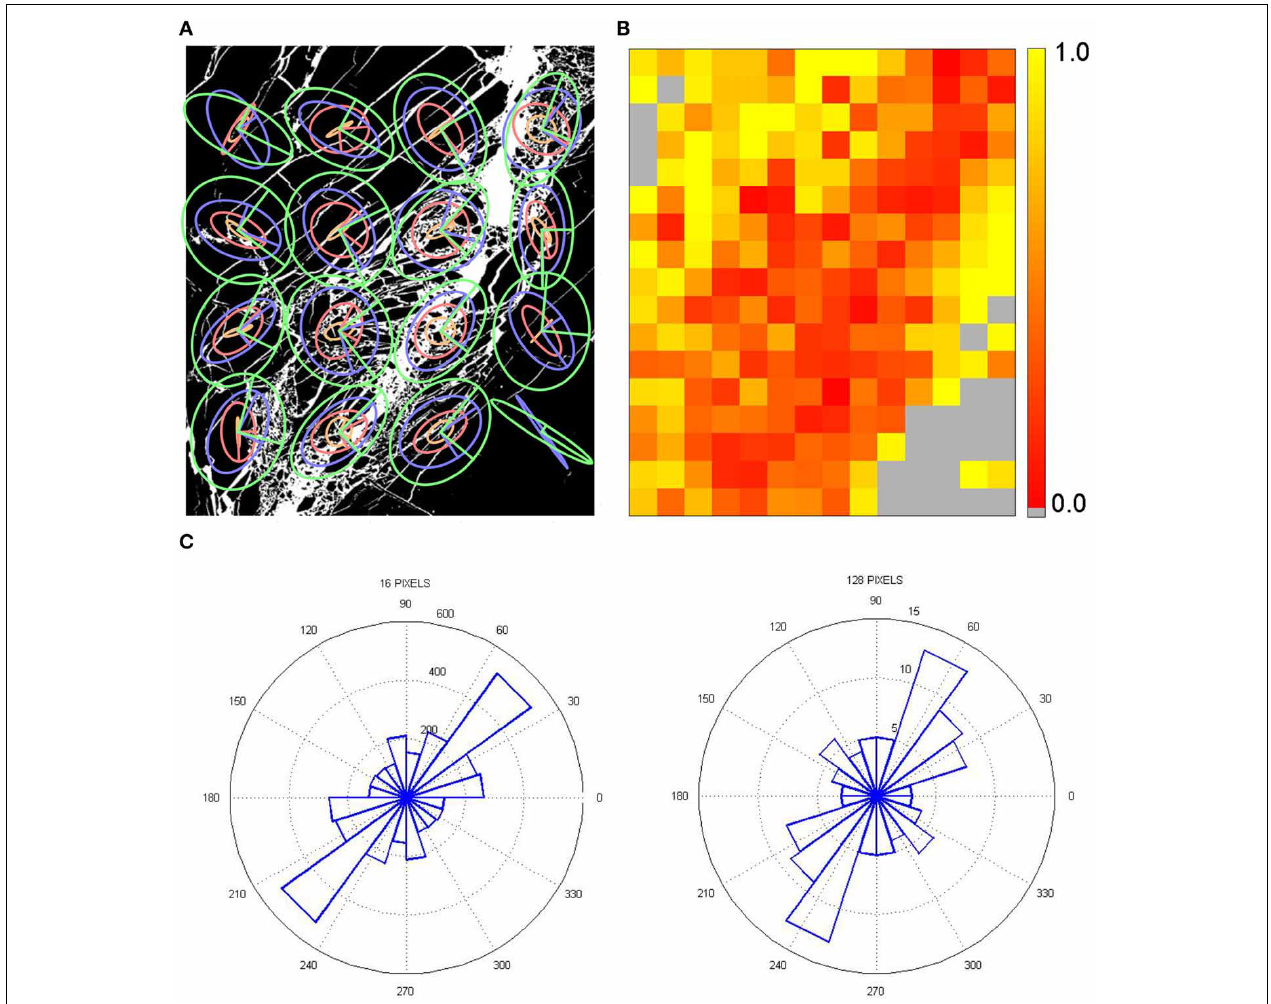
FIGURE 5 | Analysis of granite (Figure 1B). (A) Analysis in position, orientation and scale. There are 4 × 4 analysis boxes placed on a grid of 110 pixels step centered on the image. Concentric ellipses represent measurements at 32 (orange), 64 (red), 96 (blue), 128 pixels (green). (B) Map